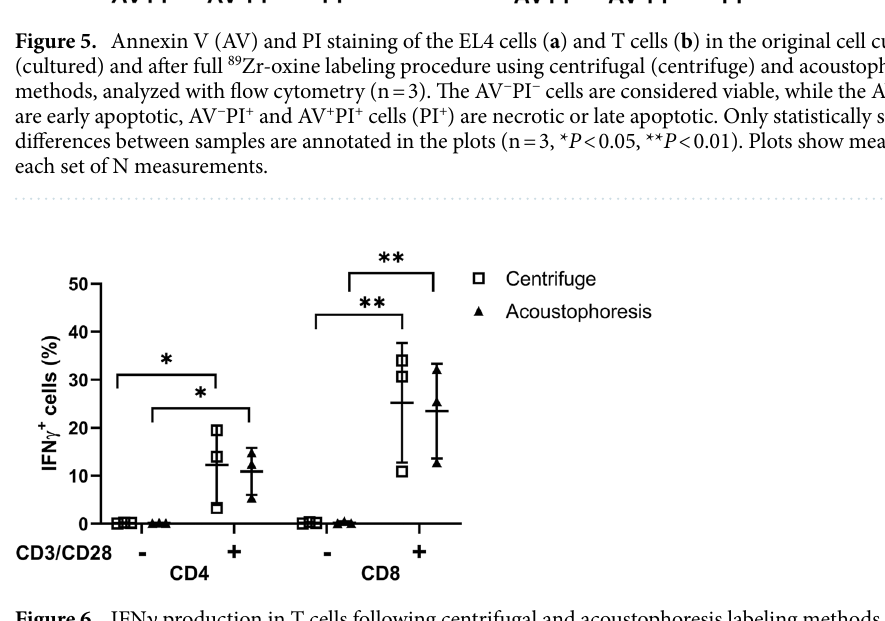
Figure 6. IFNγ production in T cells following centrifugal and acoustophoresis labeling methods. 89 Zr-oxine labeled T cells without (−) and with (+) overnight CD3/CD28 stimulation were examined for their IFNγ production within CD4 and CD8 T cell populations (n = 3, * P < 0.05, ** P < 0.01). The data show that the centrifugal and acoustophoresis labeling processes demonstrate similar cytotoxic function. Plots show mean ± SD for each set of N